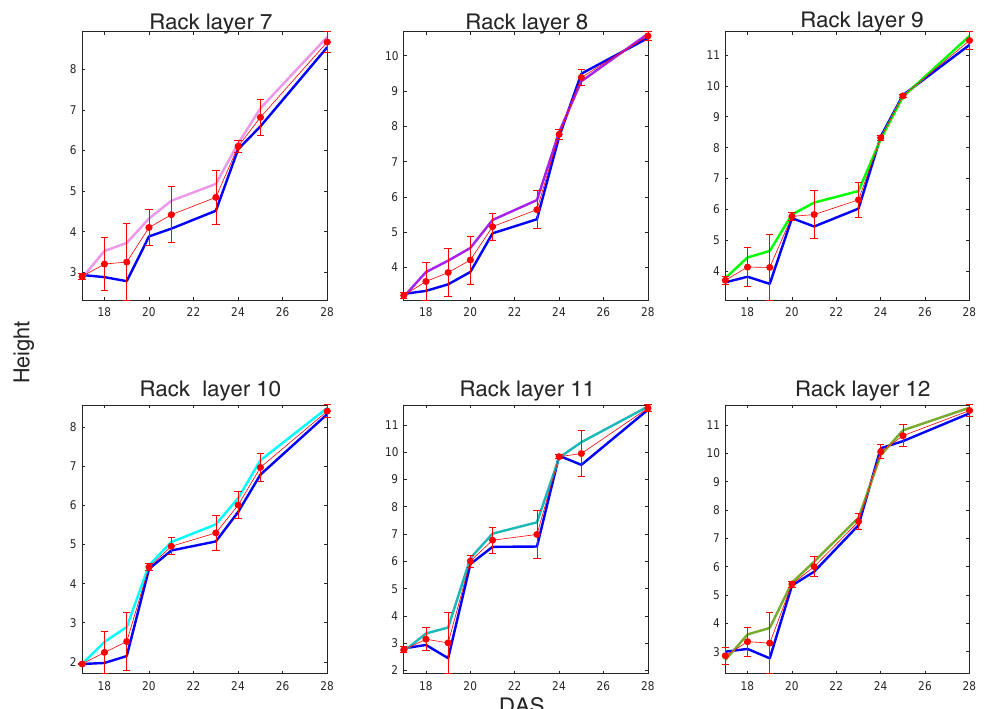
Figure 9. Plant height trends compared with ground truth, from DAS 17 to DAS 28 for Racks 7–12. Recall that Racks 7–9 have low density, while Racks 10–12 have high density plants distribution. For each graph, blue represents the ground truth height measurement taken manually, and the other colors the height predicted according to the vision based methods. Finally, the graph line in red, with red markers, and orange errors segments, shows the distance (see Equation (8)) between the ground truth and the predicted